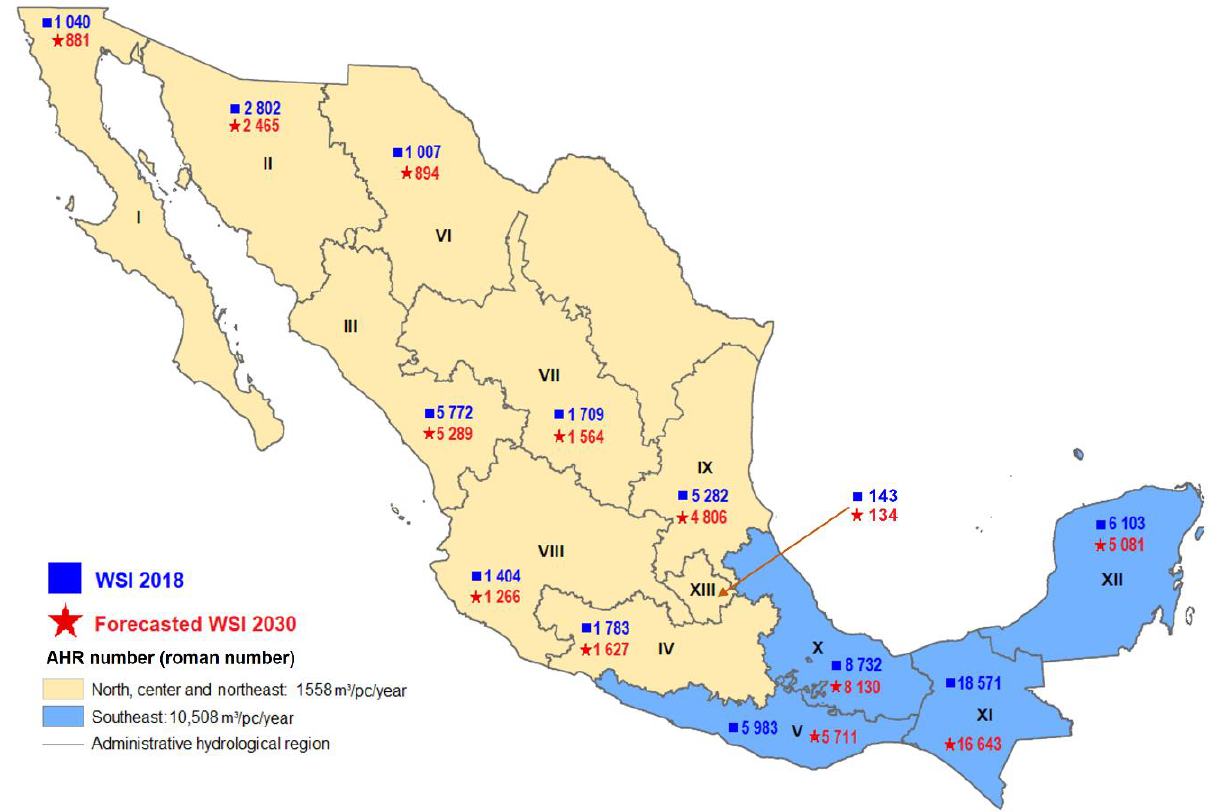
Figure 1. Water availability per AHR in Mexico [28].